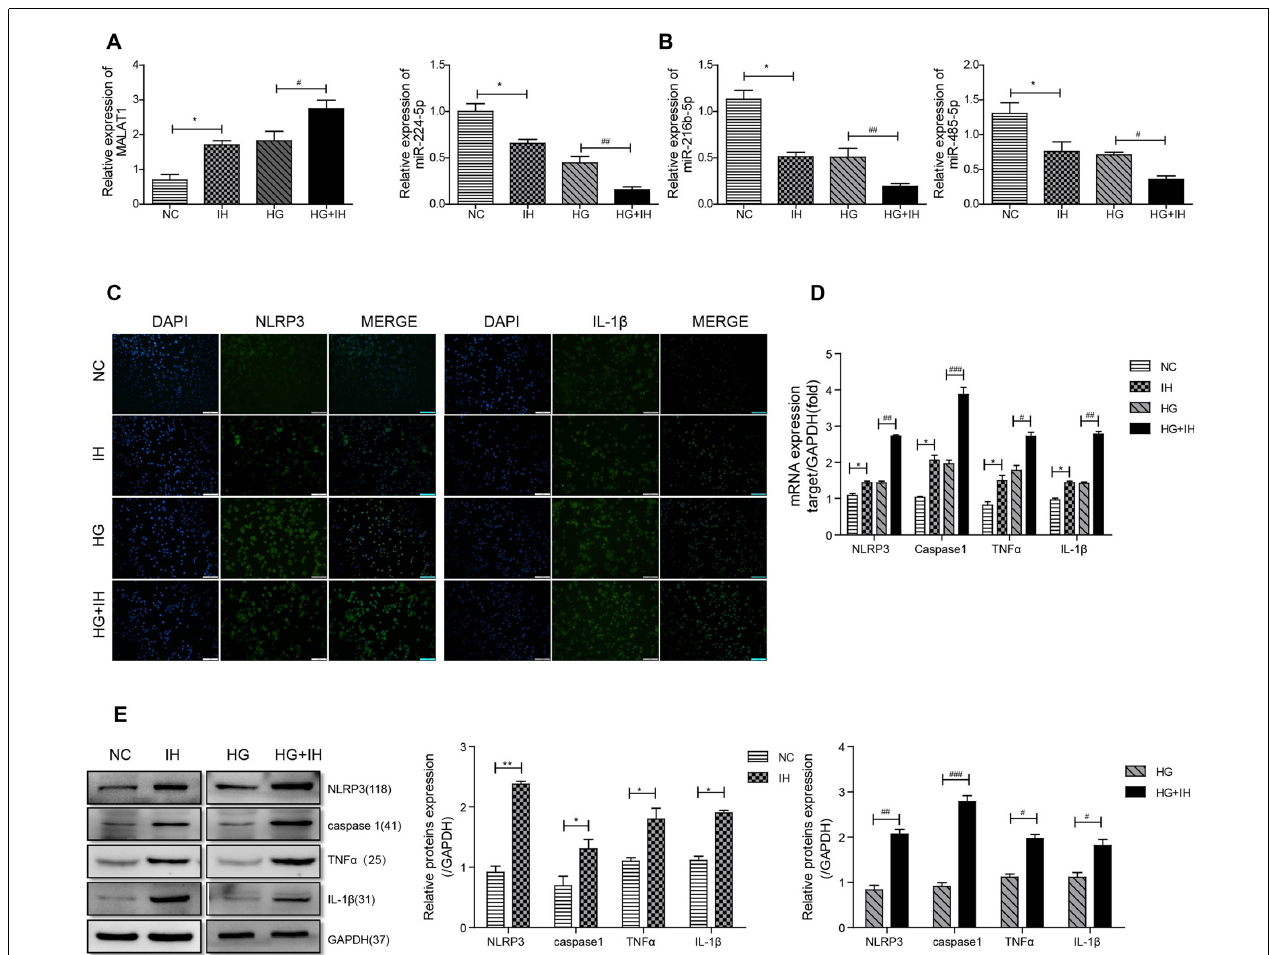
FIGURE 3 | HG (high glucose) combined with IH aggravated the activation of BV2 microglial cells and upregulated MALAT1 and downregulated miRNAs. (A,B) MALAT1 and the miRNAs miR-224-5p, miR-216b-5p and miR-485-5p were analyzed by qRT-PCR. (C) Immunofluorescence was used to analyze the expression of NLRP3 and IL-1 β in each group of BV2 cells. (D,E ) qRT-PCR and western blot were used to analyze NLRP3, caspase 1, TNF- α and IL-1 β expression levels in BV2 cells. * p < 0.05, ** p < 0.01 vs. the NC group; # p < 0.05, ## p < 0.01, ### p < 0.001 vs. the HG+IH